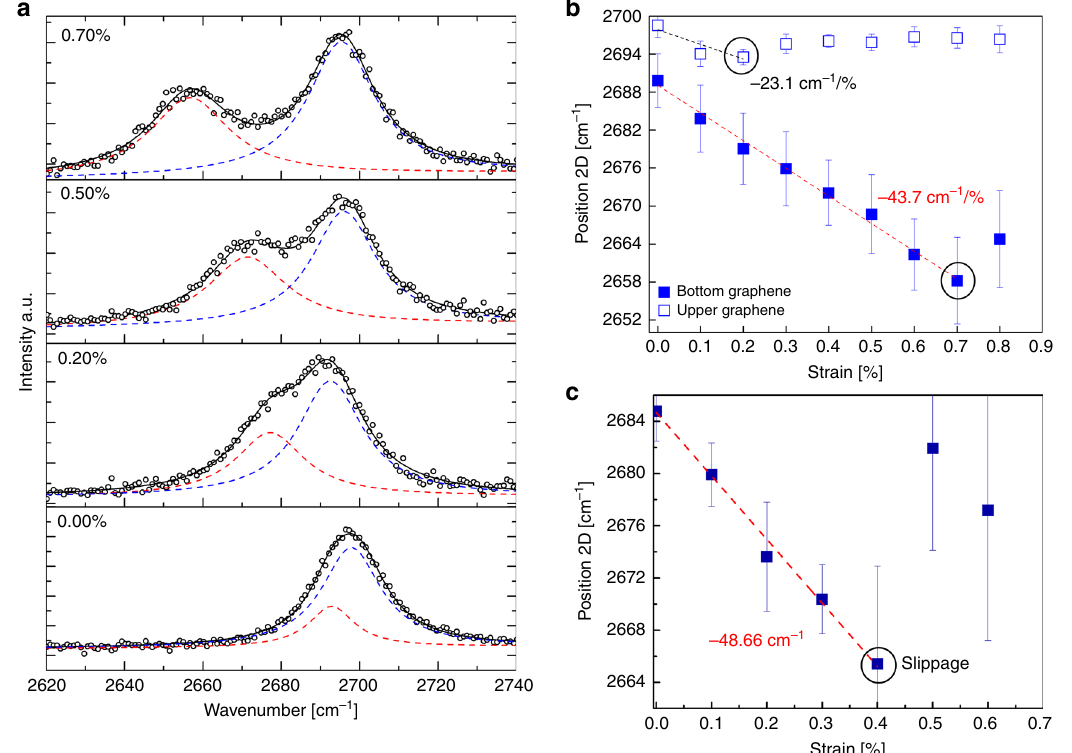
Fig. 2 The shift of the 2D peak under tension. a The evolution of the 2D peak for the folded bilayer graphene under various levels of tensile strain. b The shift of the 2D peak of the bottom and top single-layer graphenes of the folded bilayer. c The shift of the single-layer graphene solely. The error bars represent standard